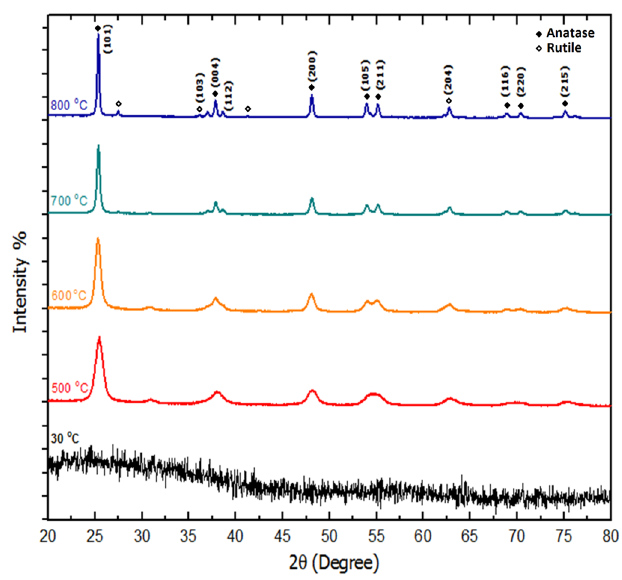
Figure 4. X ‐ ray diffraction (XRD) pattern of TiO 2 nanoparticles with various calcination temperatures.